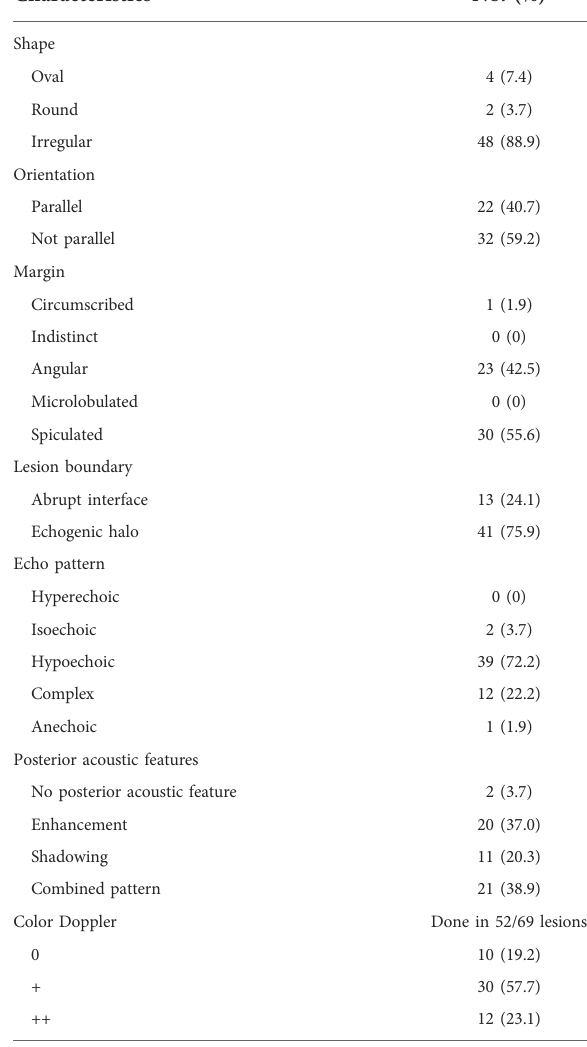
TABLE 3 Sonographic characteristics of IMPC lesions ( n =54).